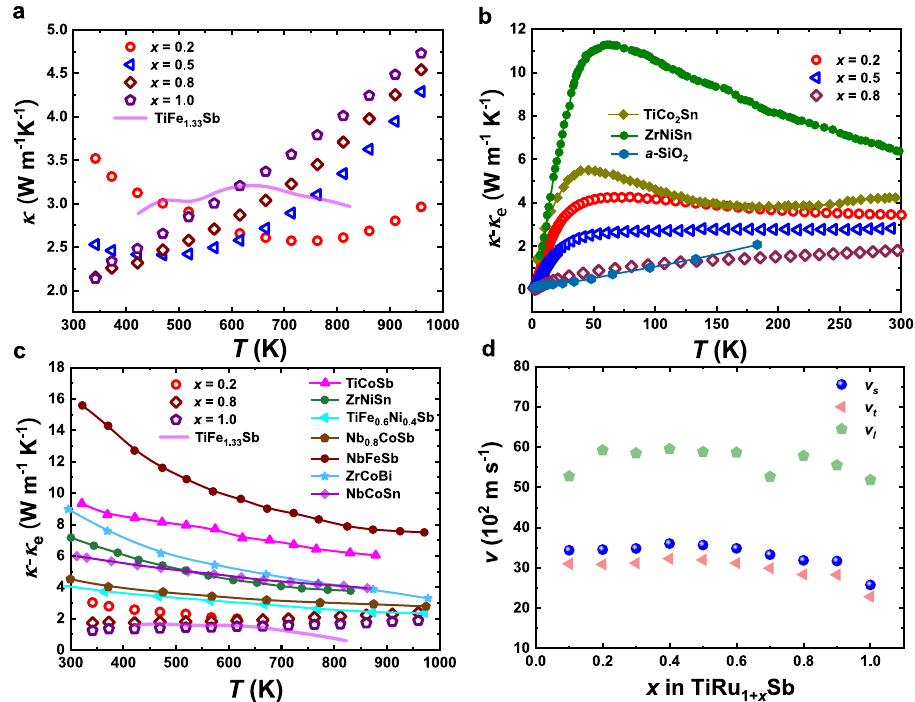
Fig. 3 Thermal transport properties of TiRu 1 + x Sb samples. a Total thermal conductivity ( κ ) above room temperature. b Lattice thermal conductivity ( κ − κ e ) from 2 to 300 K. c Lattice thermal conductivity ( κ − κ e ) in comparison with characteristic HH and FH compounds in the temperature range of 300 – 1000 K. d Ru content-dependent average ( v s ), longitudinal ( v l ), and transverse ( v t ) sound velocities. The solid lines in a – c are the experimental data of TiFe 1.33 Sb, α -SiO 2 , ZrNiSn, TiCo 2 Sn, and other typical HH compounds taken from literatures 6,15 – 22